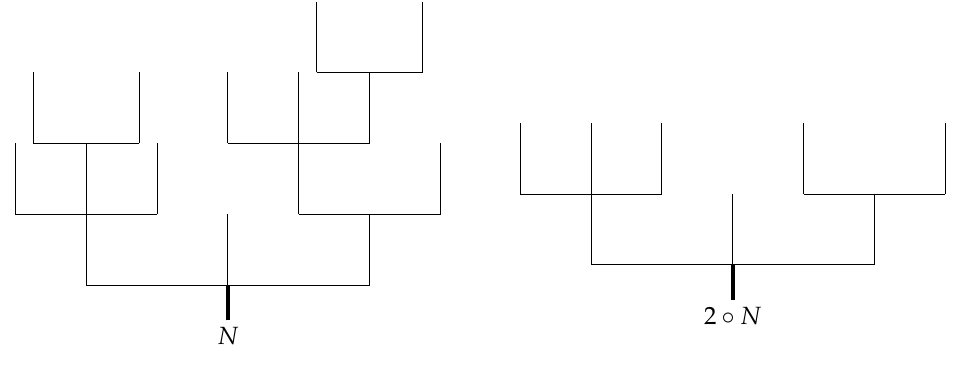
Fig3. Dendrograms of N and 2